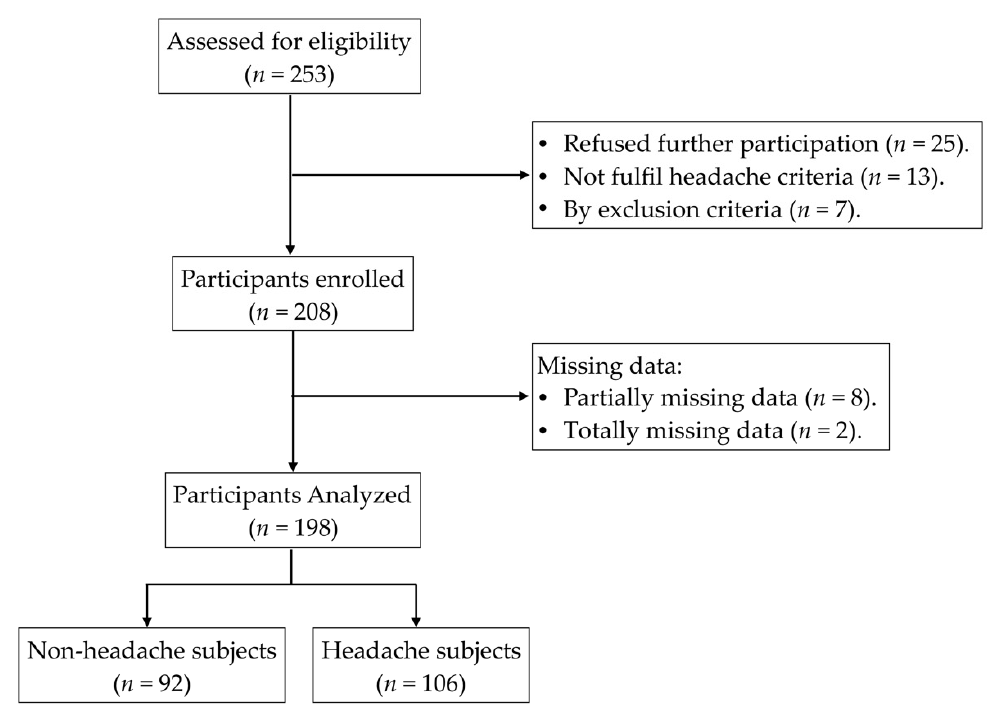
Figure 1. Flowchart of participant selection through the study.